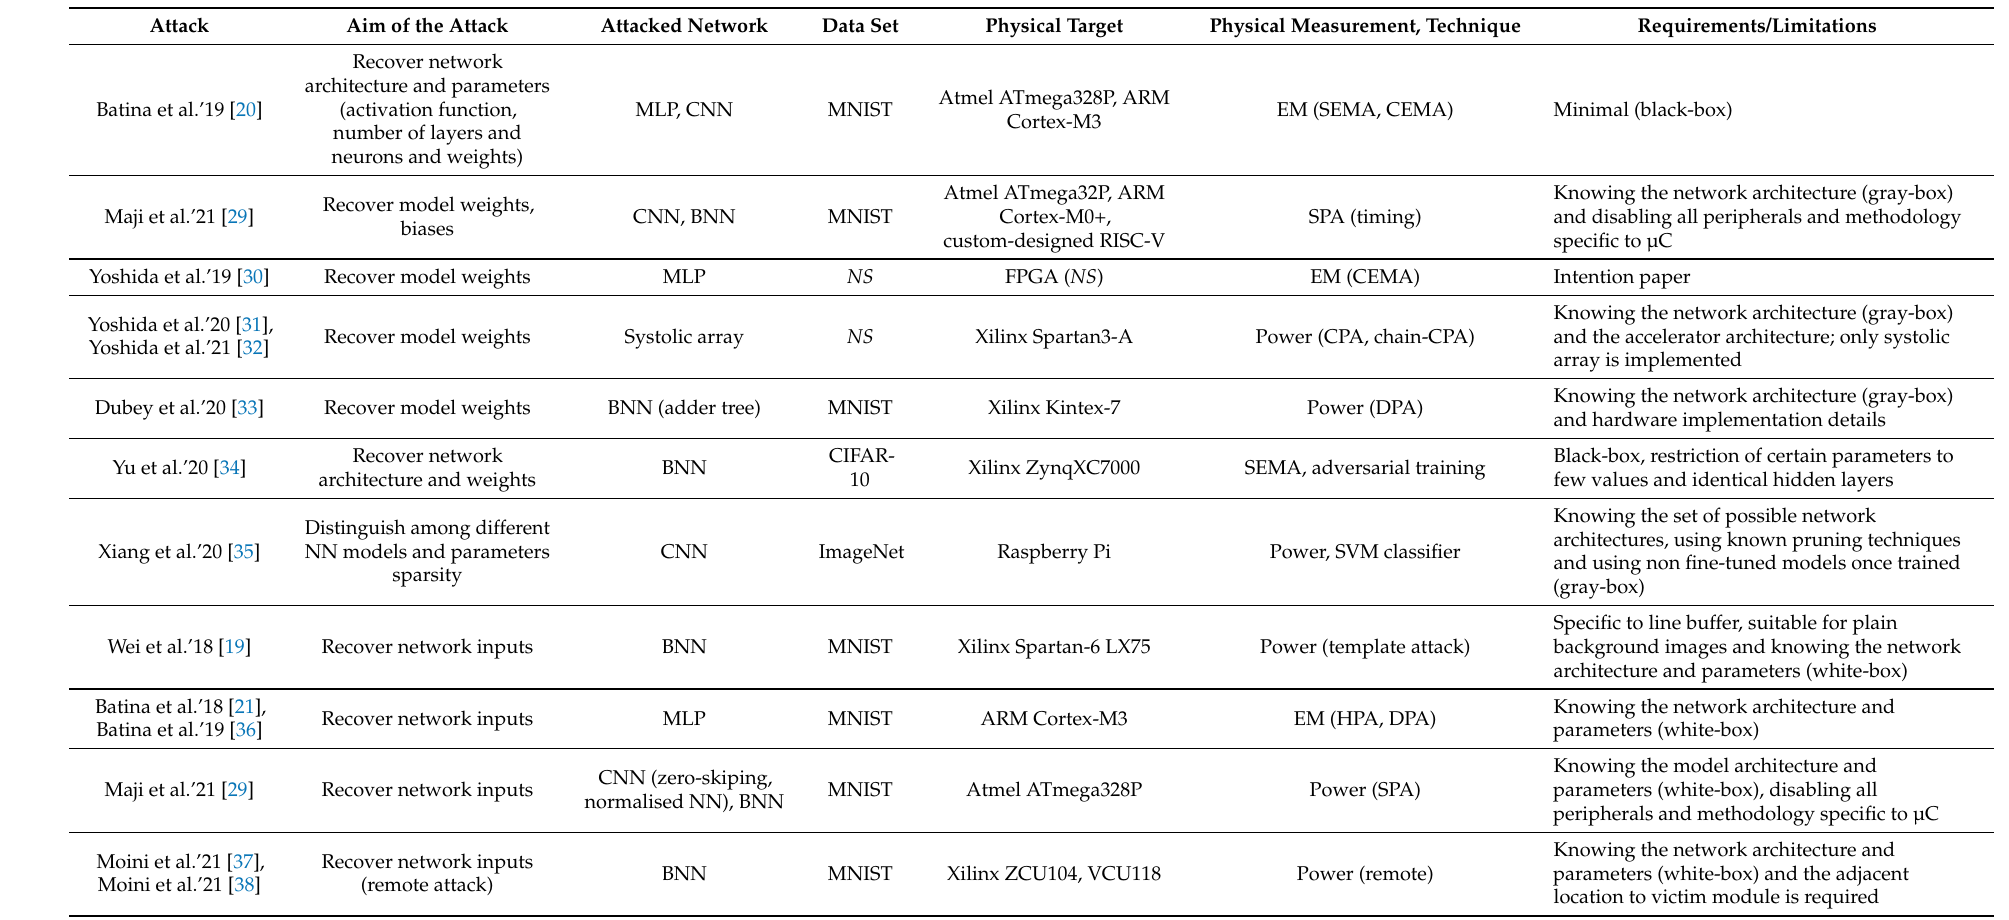
Table 1. Categorisation of attacks; NS stands for non